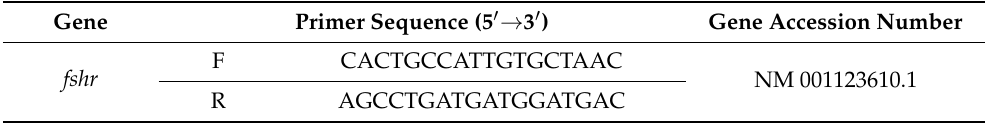
Table 1. Oligo sequences used for RT-qPCR during gene transcription analysis on testis samples. F = forward primer, R = reverse